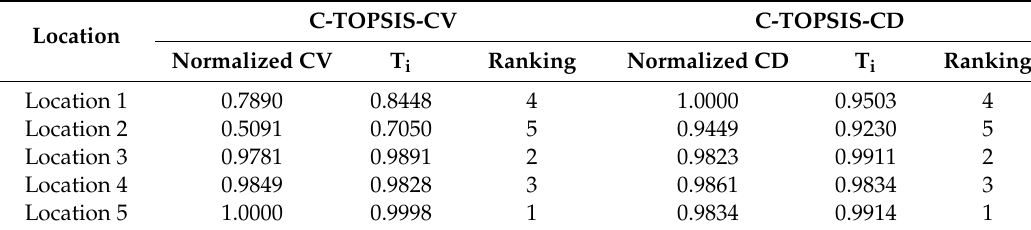
Table 8. Decision results of C-TOPSIS-CV and